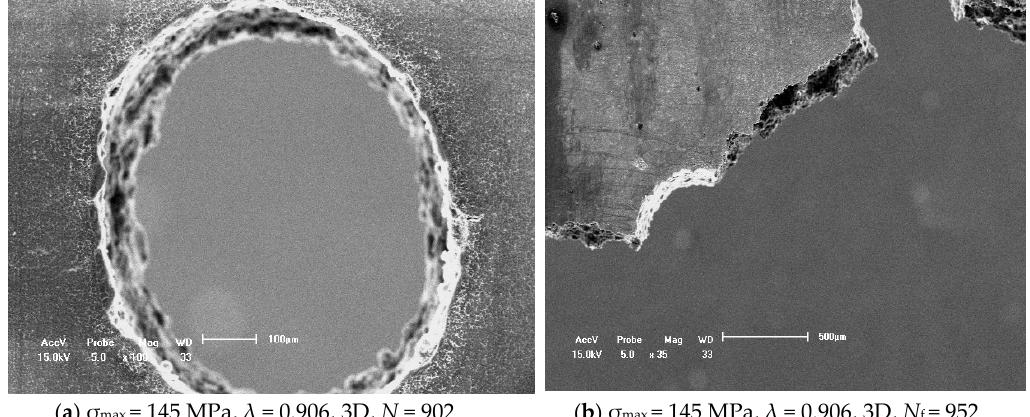
Figure 6. Effect of 45° tilted and distance 1.5 mm of two through holes on the fatigue crack propagation behavior of cast AZ91 alloy.